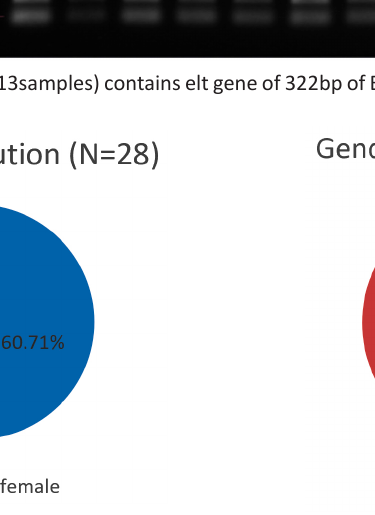
Fig. 4. Gender Distribution (N=28) ETEC E.coli Fig. 5. Gender Distribution (N=2) of EHEC E.coli